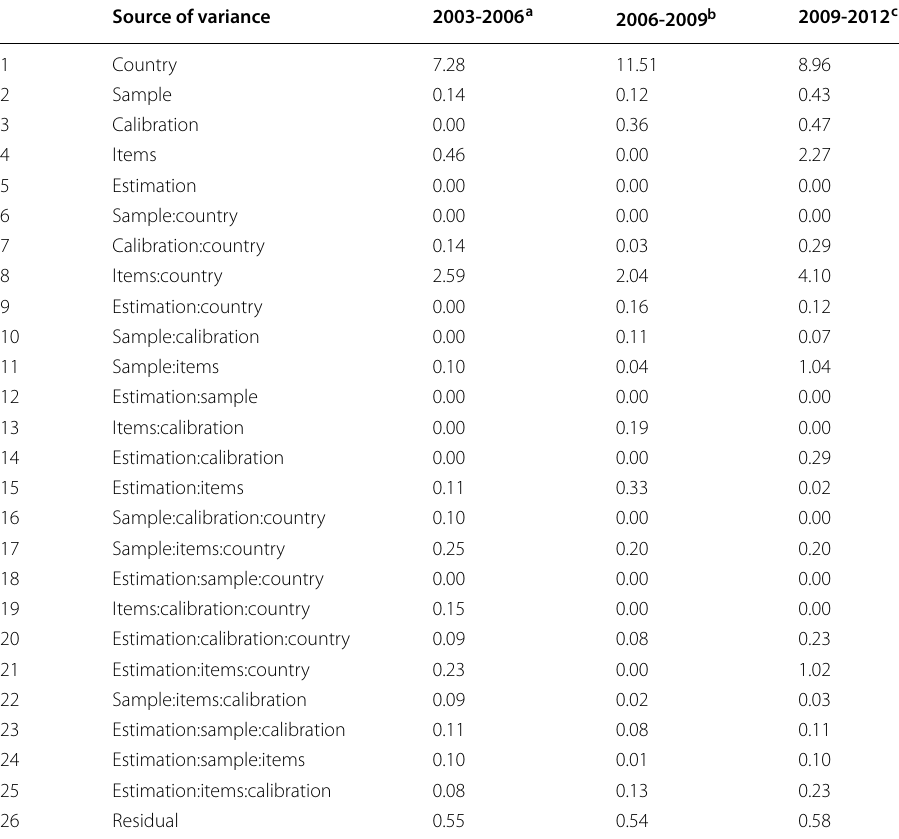
Table 4 Standard Deviations of Different Factors of Analytical Decisions for Trend Estimates in PISA Mathematics Obtained from a Variance Component Analysis